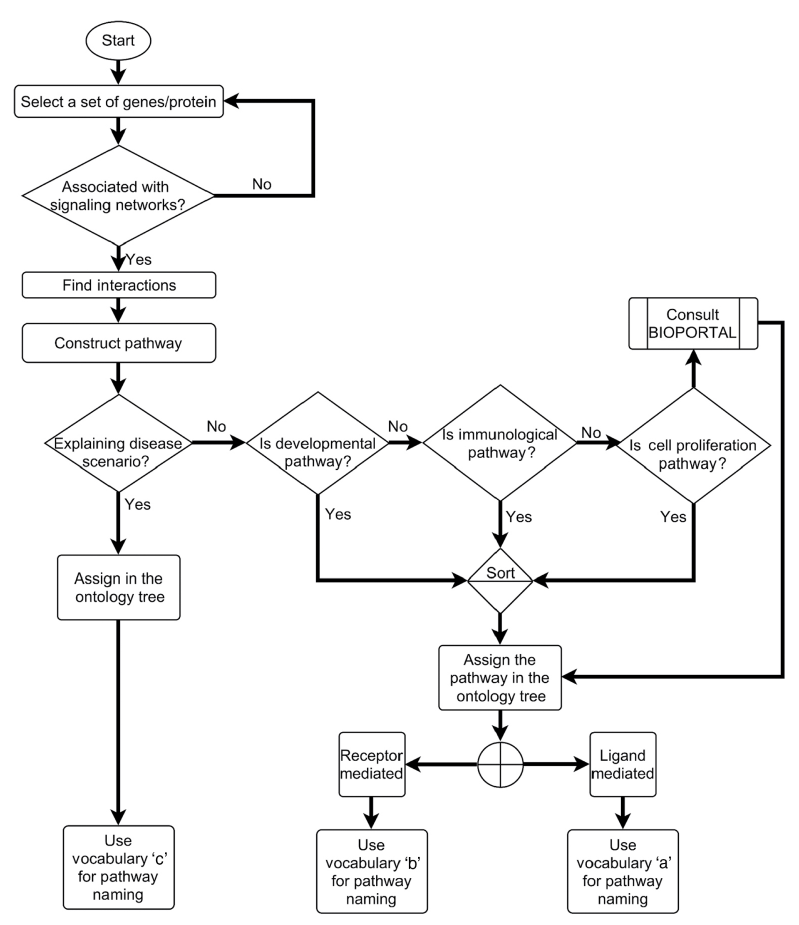
Figure 1: Flowchart describing the pathway nomenclature system used by the curators of BIOPYDB